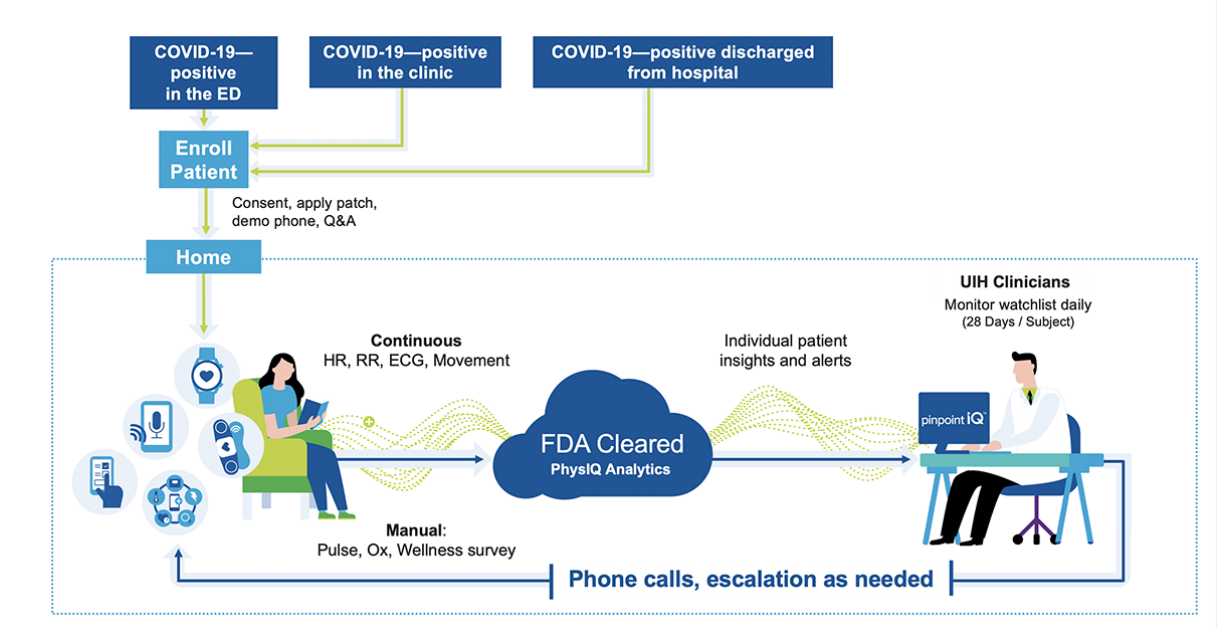
Figure 1. Study protocol. ED: emergency department, HR: heart rate, RR: respiratory rate, ECG: electrocardiography, UIH: University of Illinois Health. ©2021